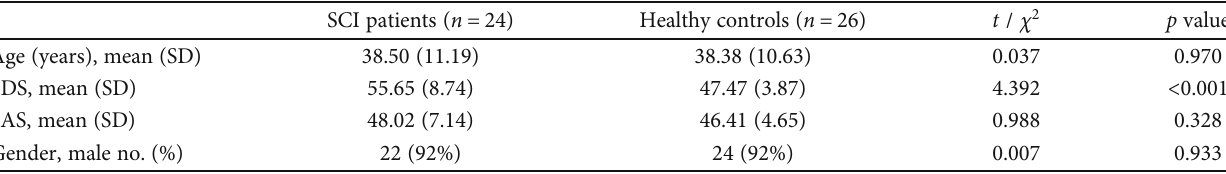
Table 2: Intergroup di ff erences of demographic characteristics and clinical